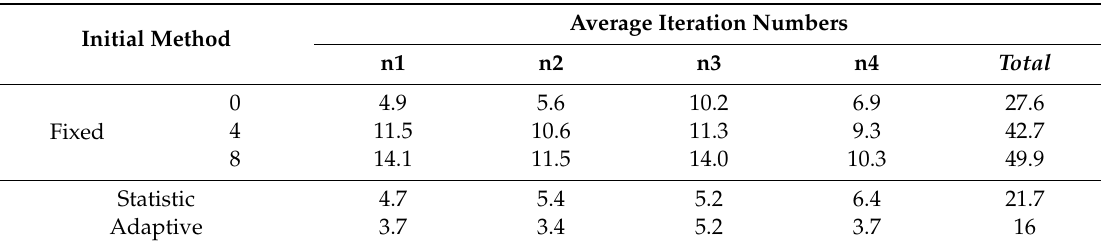
Table 4. The average iteration numbers of the fixed, statistic and adaptive method for defining the initial values with the same computation